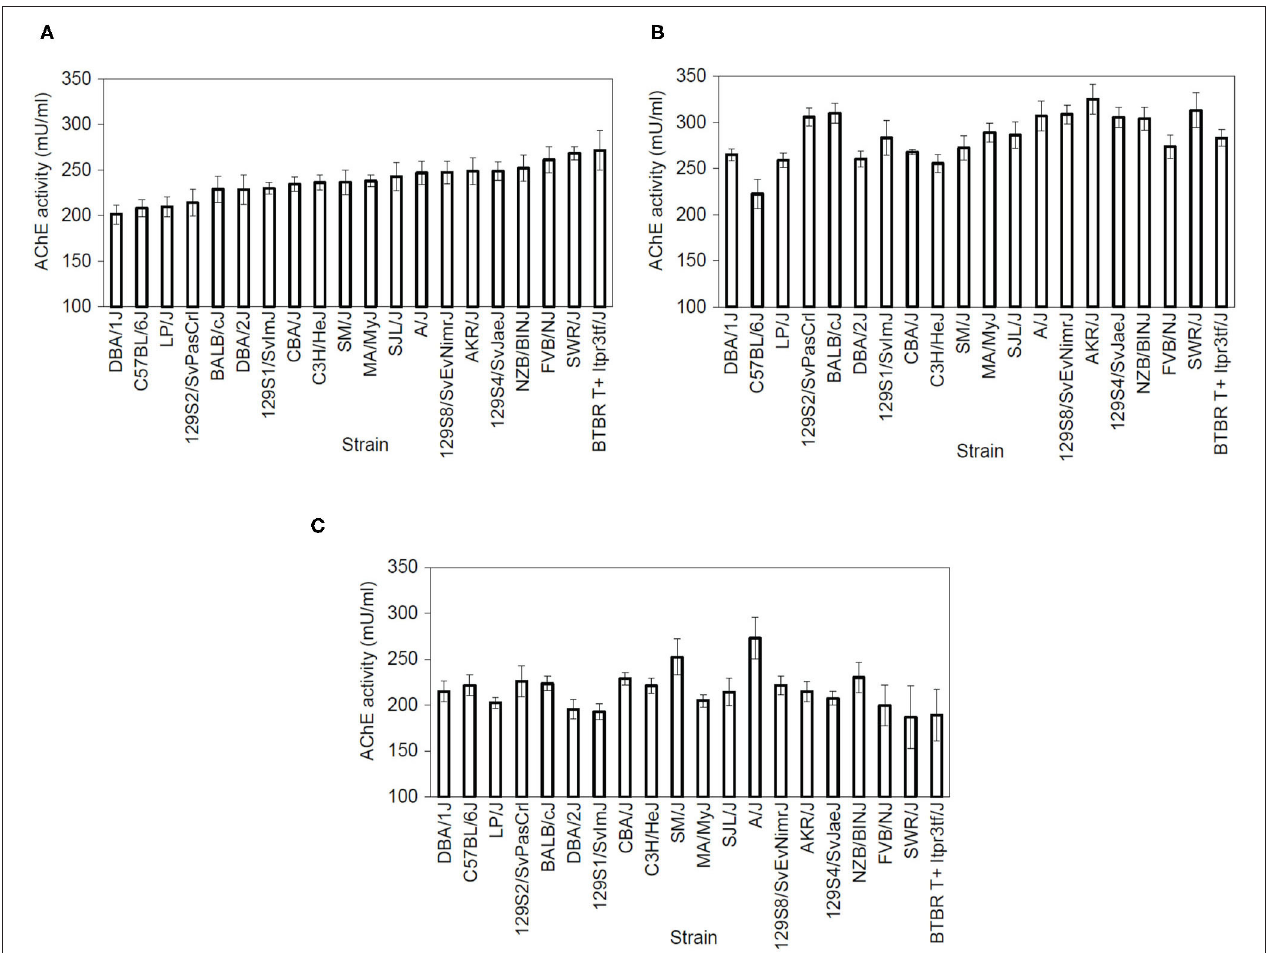
FIGURE 2 | Acetylcholinesterase activity varies by strain. AChE activity (measured in mU/mL) showed a main effect of strain in the (A) dorsal hippocampus [ F (19,99) = 2.37, p < 0.05), (B) ventral hippocampus [ F (19,100) = 4.25, p < 0.05], and (C) cerebellum [ F (19,99) = 1.81, p < 0.05] n = 8–11 per strain. Strains are shown from lower to higher AChE activity levels in the dorsal hippocampus and then follow the same order in the ventral hippocampus and cerebellum graphs. For post-hoc comparsions, please see Supplementary Materials .